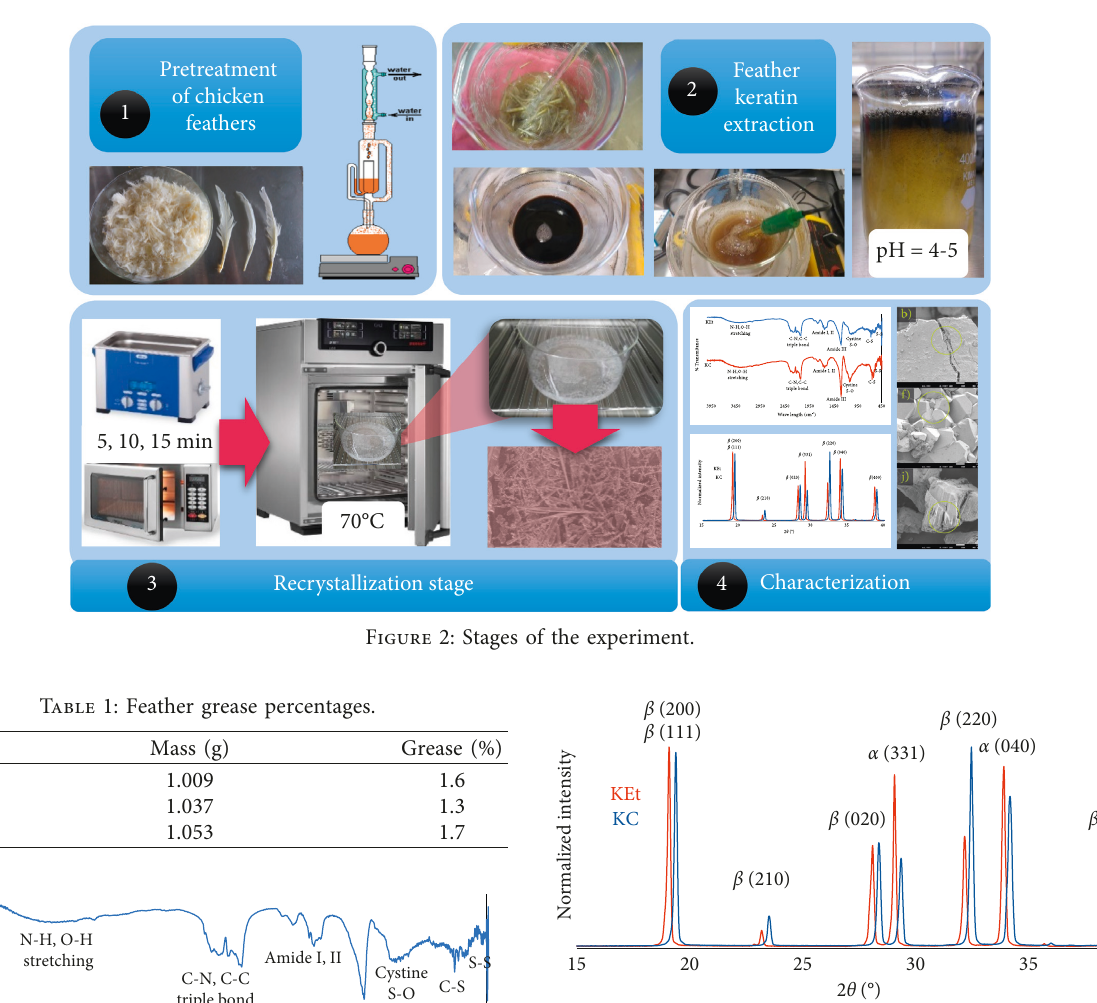
Figure 4: Diffractograms of the KC and KEt